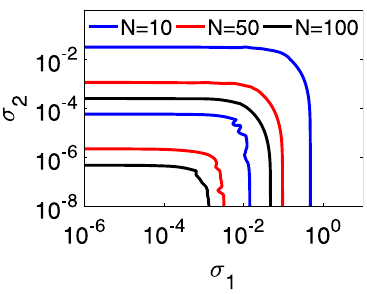
Fig. 3 Synchronization in a simplicial complex of Rössler oscillators with all-to-all coupling. Lower and upper boundary curves for the region where synchronization is stable, at different values of N . The color codes for the different curves is reported at the top of the panel.